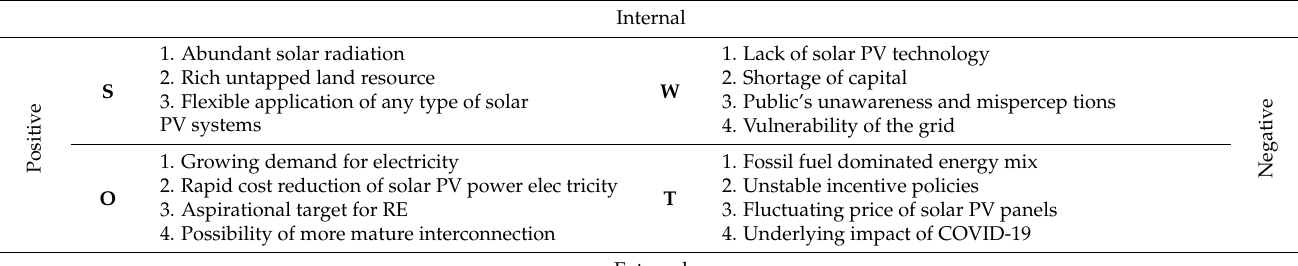
Table 2. SWOT analysis results for the development of solar PV power in